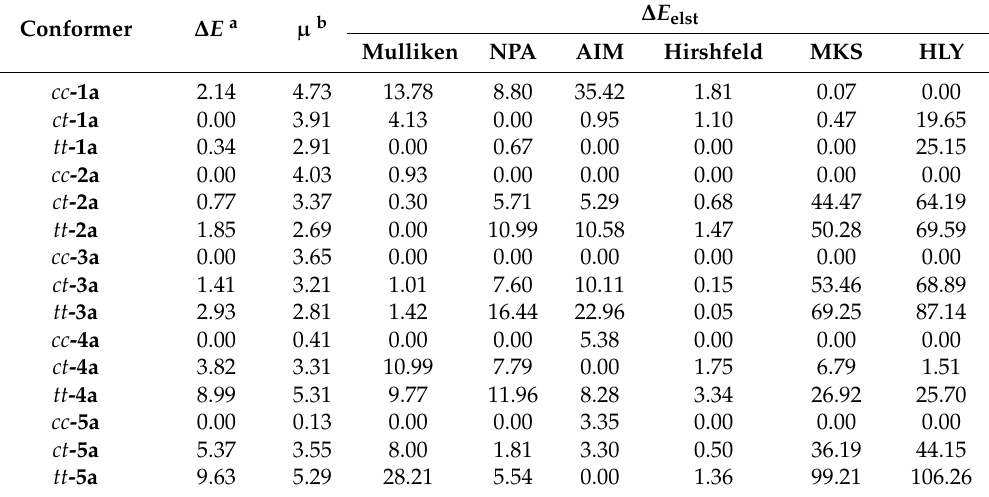
Table 1. Relative electron energies ( ∆ E in kcal/mol), dipole moments obtained from the full density ( µ in Debyes) and relative electrostatic energies ( ∆ E elst in kcal/mol) for 1a – 5a in their three conformations. All the results are calculated at the B3LYP/def2-QZVPP level of